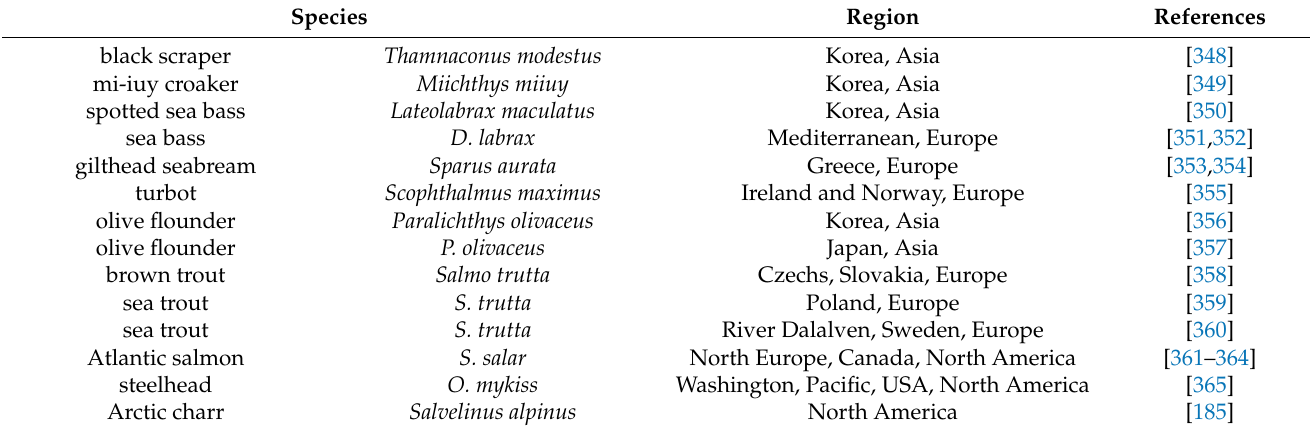
Table 4. Comparison of wild populations and hatchery stocks based on the use